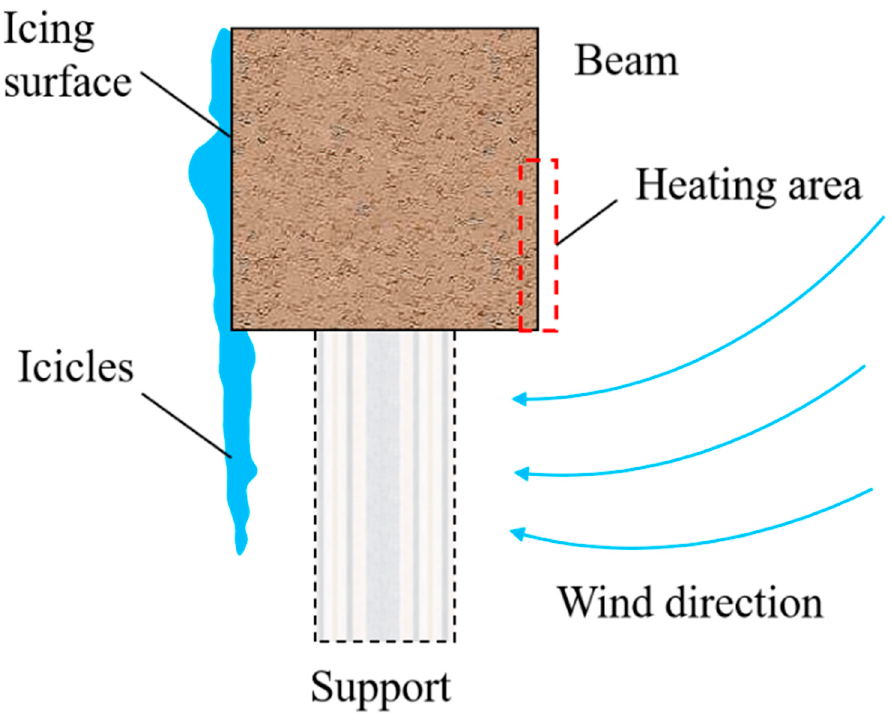
Figure 4. The wind direction diagram from the side view.